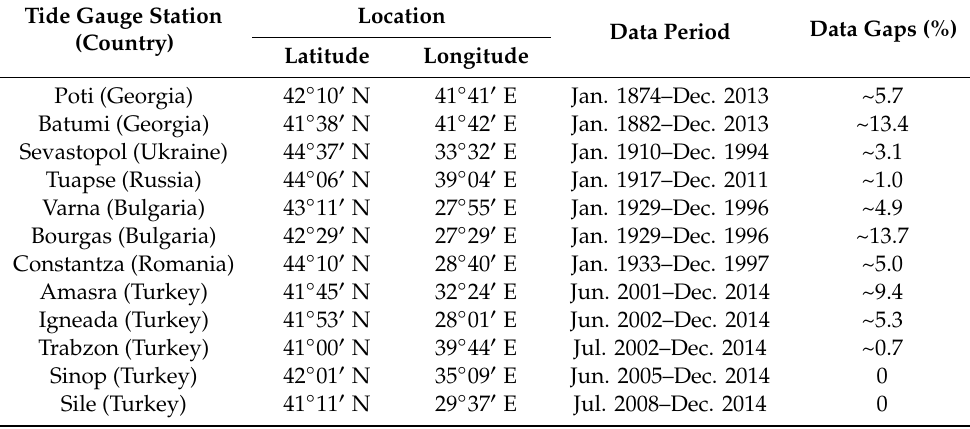
Figure 3. Locations of the tide gauges and Global Navigation Satellite System (GNSS) stations used in the study. Table 1. General information on all the tide gauge stations used in this